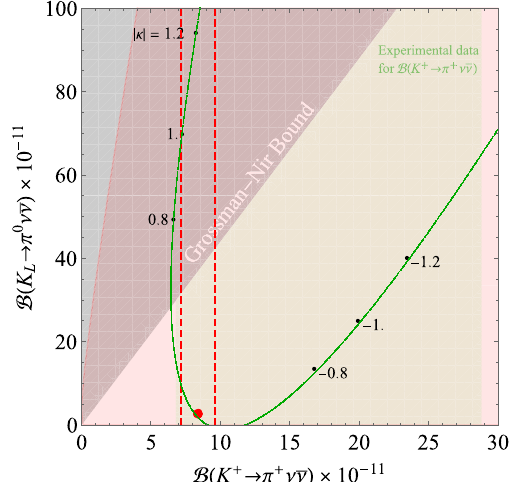
Fig. 4 Rates covered by Eq. 14 of [1] (corrected as in Eq. 1 above) are illustrated in pink along with the BNL result in green and the GN exclusion in grey. The SM central values are shown as the large red dot and the dashed vertical lines correspond to ± 3 σ from the central SM value of B K + . The green curve for φ κ = 45 ◦ is chosen to illustrate ∼ 10 − 9 while keeping B values that can produce B K K + near its SM L